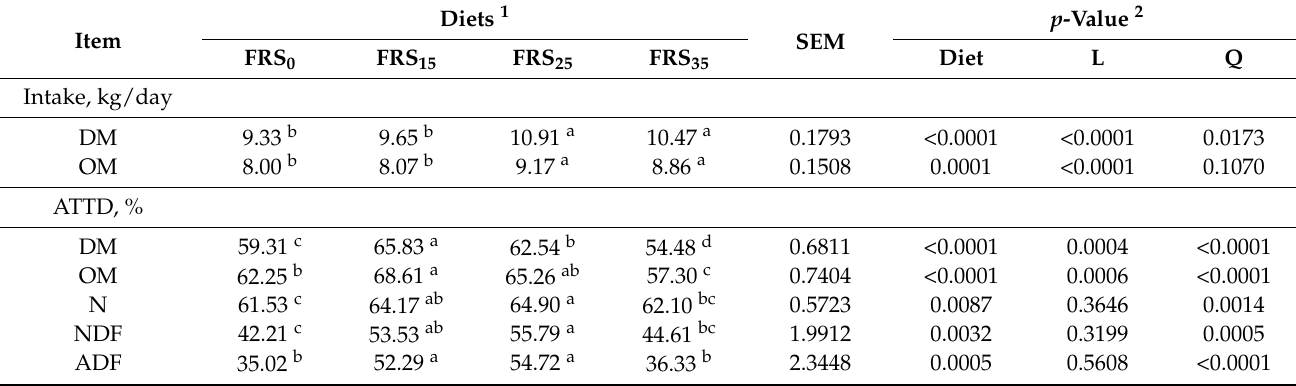
Table 3. Feed intake and apparent total-tract digestibility in lactating buffaloes fed the four experimental